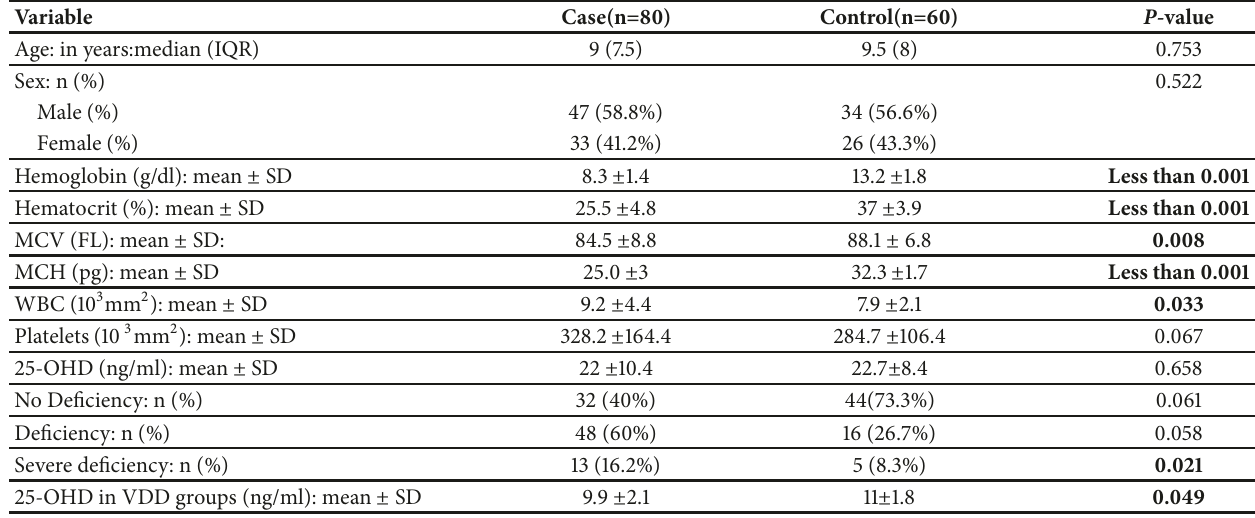
Table 2: Demographic and laboratory data of the case and control